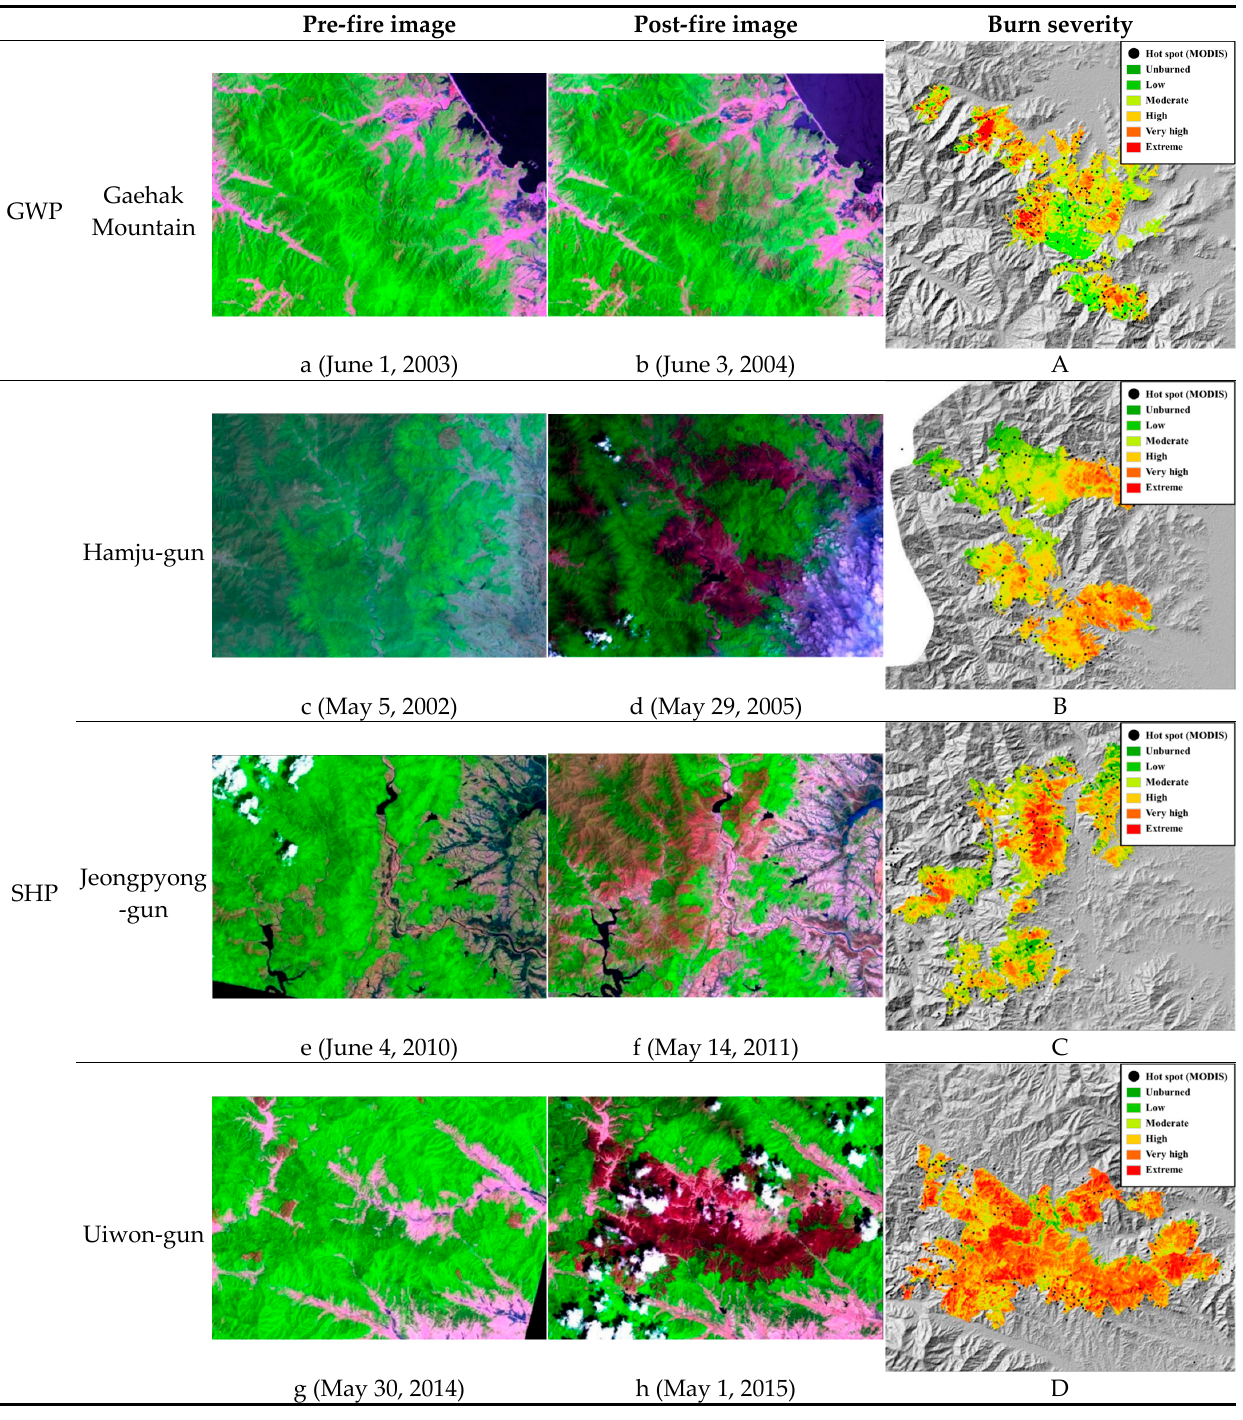
Figure 7. Burn severity maps of large fires. ( A ) The Gaehak large fire; ( B ) The Hamju large fire; ( C ) The Jeongpyong large fire; ( D ) The Uiwon large